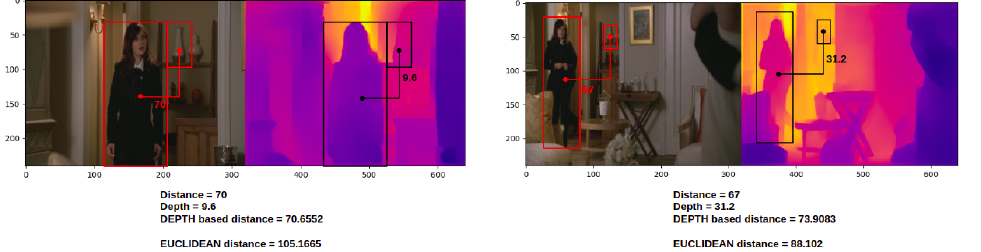
Figure 12. An example of ablation experiment to study the effect of depth in spatial distance estimation. Depth-based distance is found to be more comparable and less